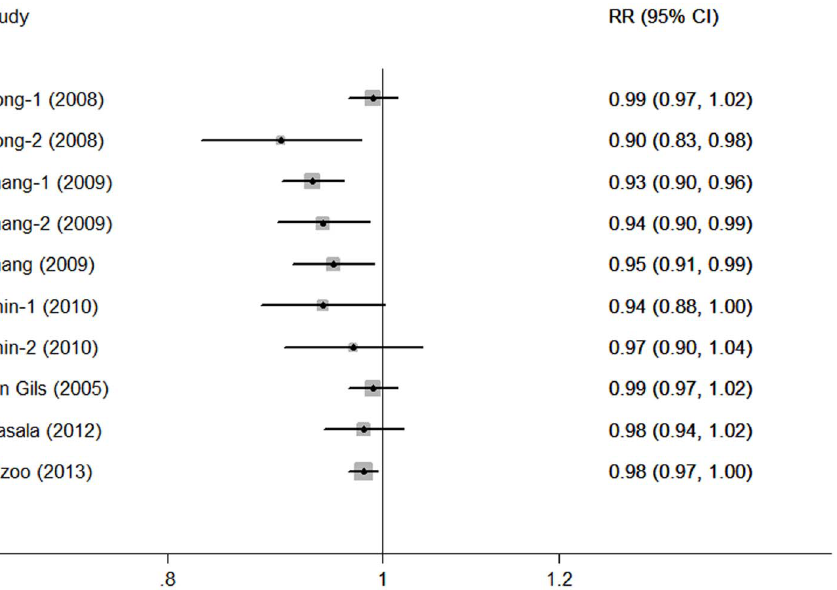
Figure 3. Study-specific dose-response analyses for the relationship between mushroom consumption and risk of breast cancer.